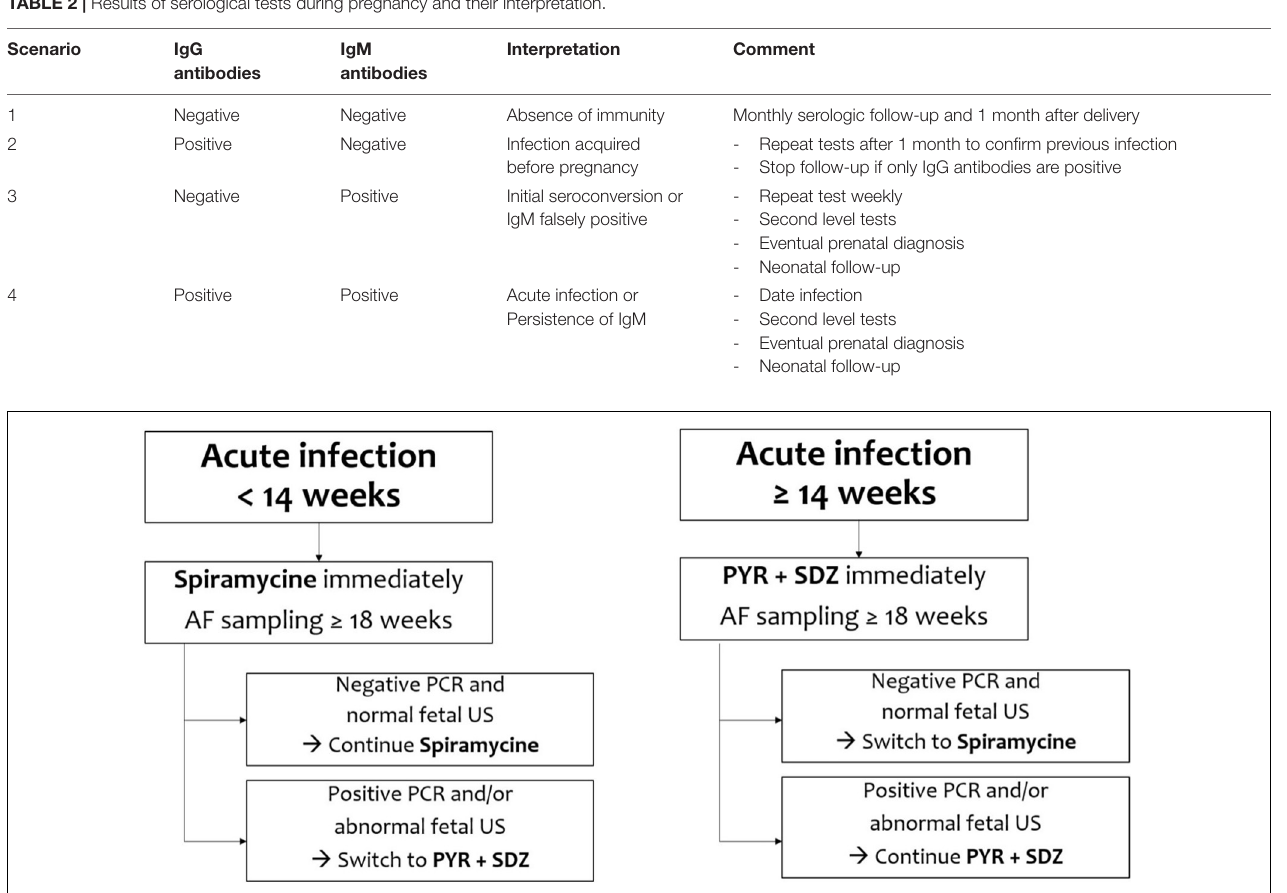
TABLE 2 | Results of serological tests during pregnancy and their interpretation.